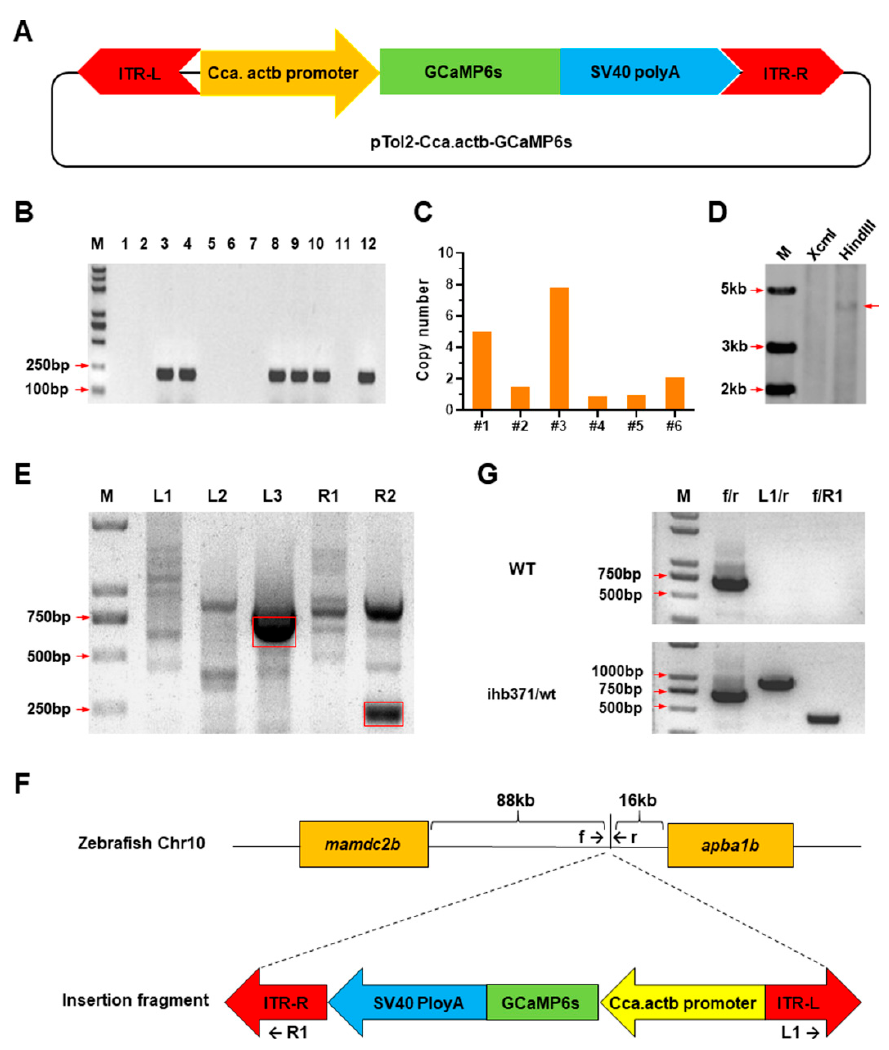
Figure 1. Generation of Tg[Cca.actb:GCaMP6s](ihb371Tg) transgenic zebrafish. ( A ) Schematic of the pTol2-Cca.actb-GCaMP6s construct. ITR-L and ITR-R, left and right inverted terminal repeats of Tol2 transposon; Cca.actb promoter, promoter of the common carp β -actin ( actb ) gene. Directions of the arrows and arrow heads are the same as the transgenic elements they represented. The transgenic elements were shown in different color for clear discrimination. ( B ) PCR screen of positive P0 individuals. M: DNA marker; 1 to 12: fish number. ( C ) Transgene copy number of the positive F1 individuals detected by qPCR assay. The x-axis represents fish number. ( D ) Southern blotting confirmed a single copy of the transgene in the genome of F1 transgenic zebrafish. The genomic DNA was digested by XcmI and HindIII, respectively. ( E ) Cloning flanking sequences of the transgene through genome walking. L1 to L3: products of the first to third round of PCR reactions using primers located on ITR-L; R1 and R2: products of the first and second round of PCR reactions using primers located on ITR-R. ( F ) Schematic of the integration site of the transgene in zebrafish genome. The insertion site is 88 kb downstream of the mamdc2b gene and 16 kb upstream of the apba1b gene on chromosome 10. The arrows indicate primers used for genotyping. ( G ) Genotyping of the transgenic zebrafish. PCR assays using primer pairs amplifying both ends of the transposon demonstrate the integrity of transgene cassette. This transgenic fish line was submitted to the China Zebrafish Resource Center (CZRC) under the accession number ihb371.